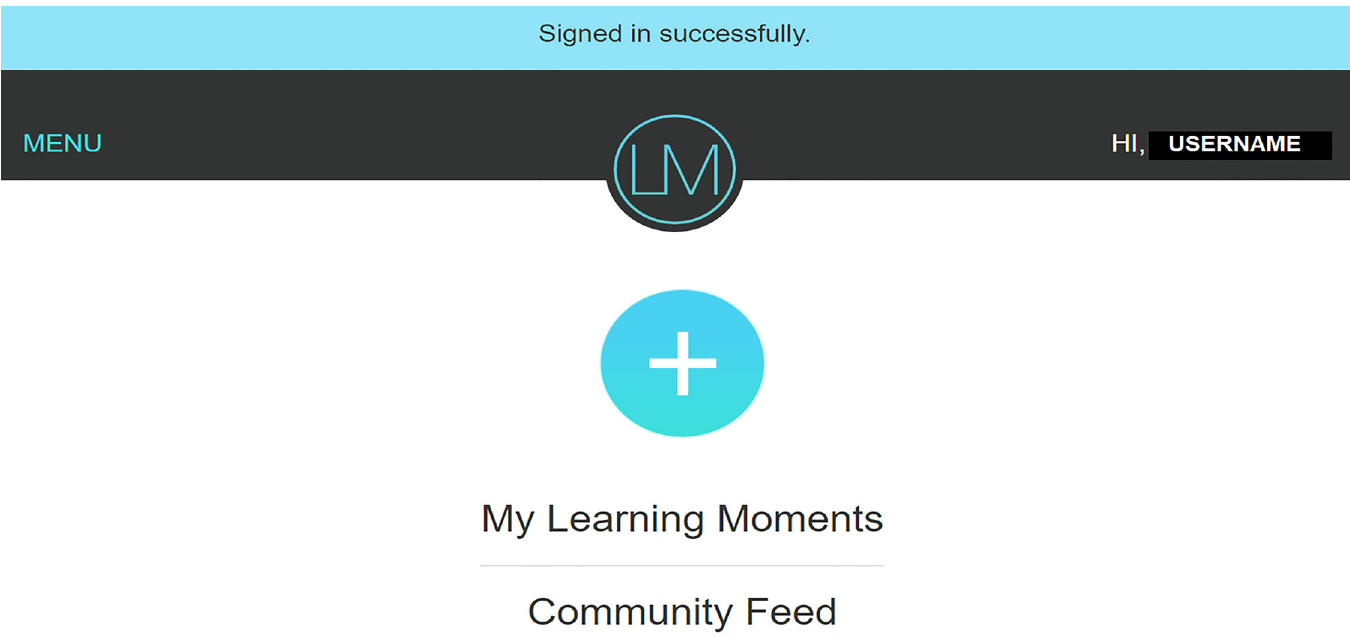
Figure 2. Learning Moment